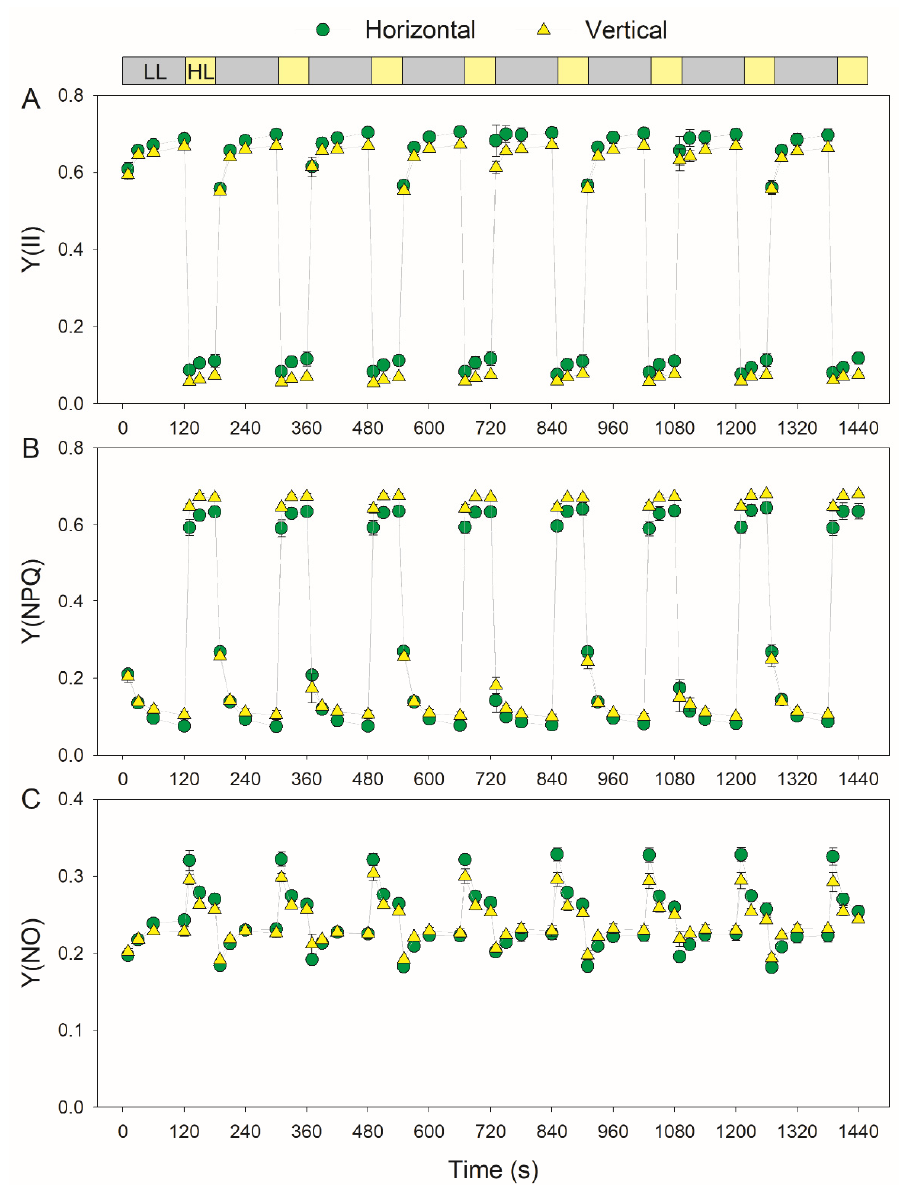
Figure 4. Changes in the PSII parameters under fluctuating light in the horizontal (leaf angle = 0 ◦ ) and vertical (leaf angle = 60–65 ◦ ) leaves. After illumination at 1809- µ mol photons m − 2 s − 1 for 20 min for photosynthetic induction, the leaves were exposed to fluctuating light alternating between 59- and 1809- µ mol photons m − 2 s − 1 every 2 min for 24 min. ( A ) Y(II), the effective quantum yield of PSII photochemistry; ( B ) Y(NPQ), the quantum yield of regulatory energy dissipation in PSII; and ( C ) Y(NO), the quantum yield of nonregulatory energy dissipation in PSII. Data are shown as the means ± SE ( n = 3).